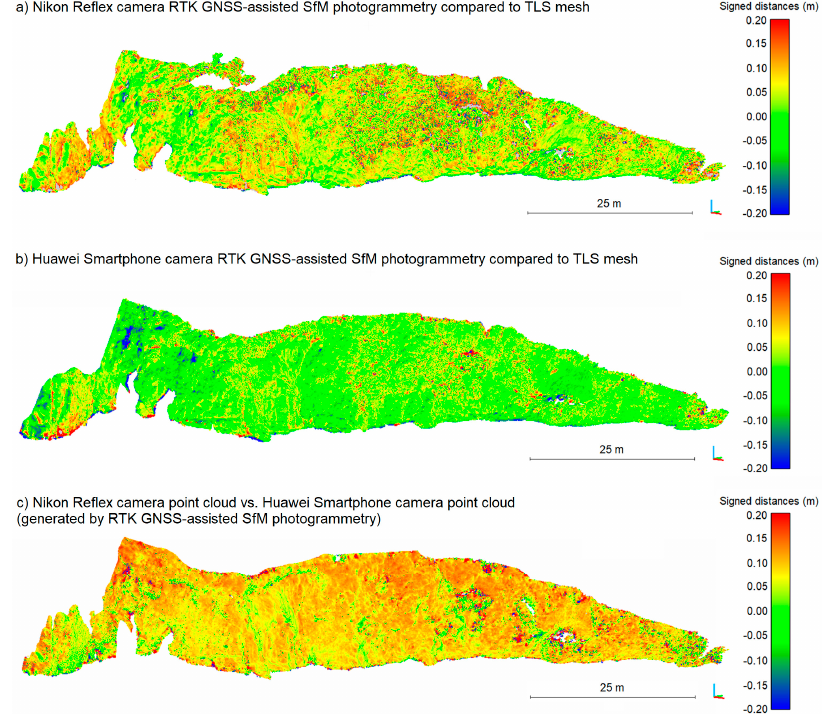
Figure 7. ( a ) Distances between the TLS mesh (used as reference) and the Nikon Reflex camera RTK GNSS-assisted SfM point cloud. ( b ) Distances between the TLS mesh and the Huawei Smartphone camera RTK GNSS-assisted SfM point cloud. ( c ) Inter-comparison of the SfM point clouds produced using the RTK GNSS-assisted terrestrial photogrammetry method.